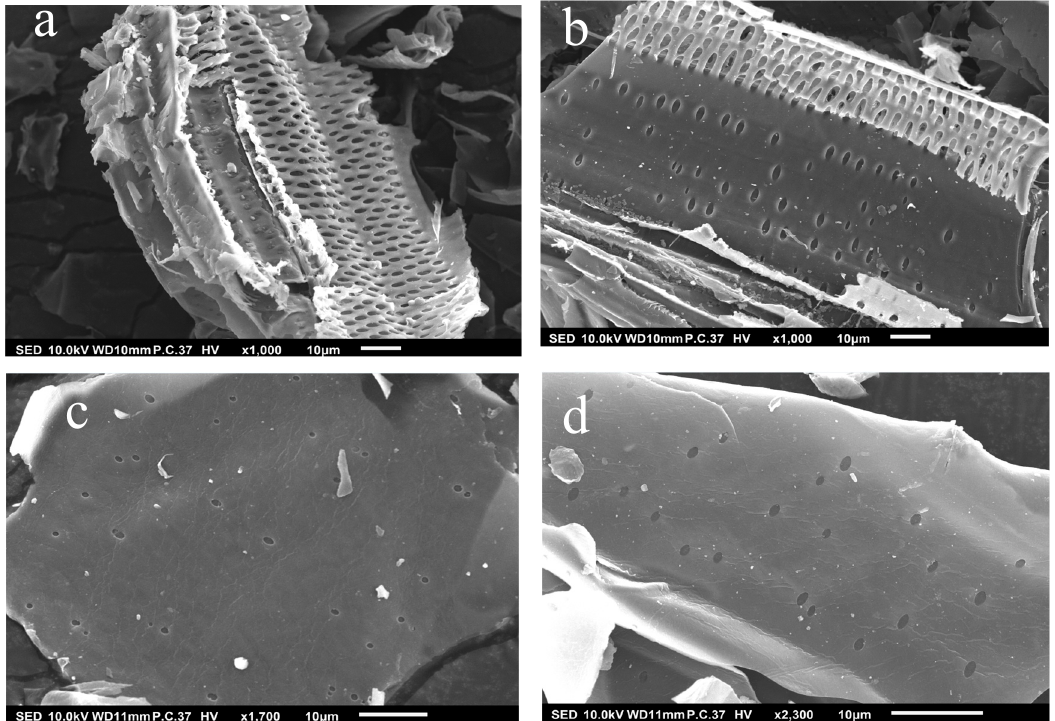
Figure 2. SEM images of ( a ) SCB350, ( b ) SCB450, ( c ) SCB550, and ( d ) SCB650.